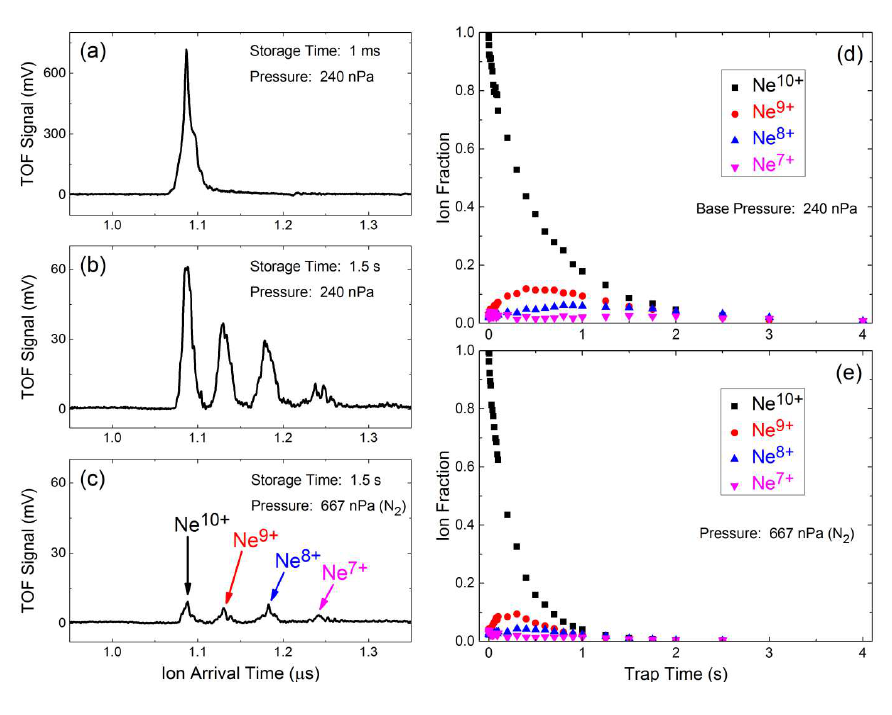
Figure 6. Observed electron capture by fully-ionized neon stored in a unitary Penning trap. ( a ) The TOF signal of Ne 10+ within 1 ms of capture; ( b ) the TOF signal after 1.5 s of storage time at base pressure; ( c ) the TOF signal after 1.5 s of confinement in 667 nPa of nitrogen; ( d ) the charge state evolution at base pressure; and ( e ) the charge state evolution in 667 nPa of